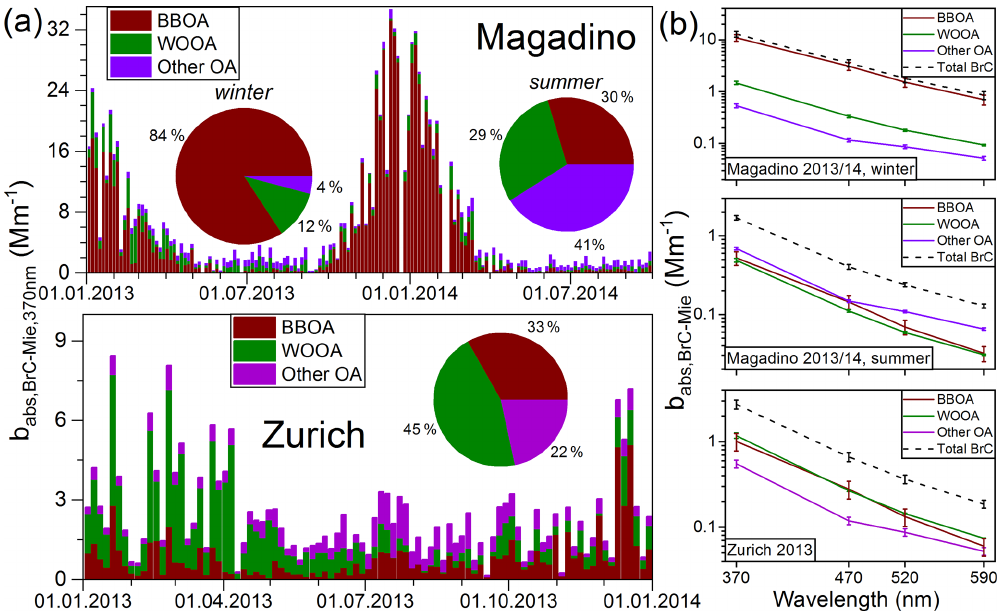
Figure 3. (a) Time series of the cumulative BBOA, WOOA and other OA (Magadino: HOA + fOOA + SOOA; Zurich: HOA + COA + SOOA) average (from seven cases; Sect. S5) factor contributions to UV–vis–PMF-based Mie-predicted particulate BrC absorption at 370nm for Magadino and Zurich. The insets show the seasonal and yearly average (summer: April–September) factor relative contributions to b abs , BrC − Mie , 370nm . Note the different temporal coverage and the different range of b abs values between the upper and lower panel. (b) Factor-specific particulate BrC absorption coefficient at four AE33 wavelengths for three distinct cases. Error bars correspond to the MAC / MAE uncertainty from the seven cases (Sect.